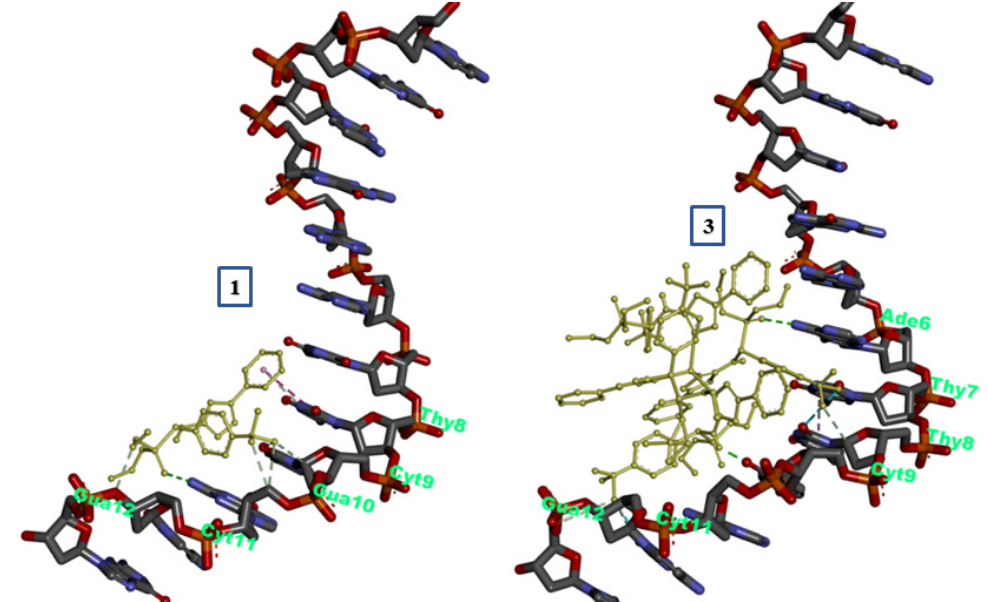
Figure 9. Interaction residue and amino acids of DNA crystal structures with 1 and 3 .